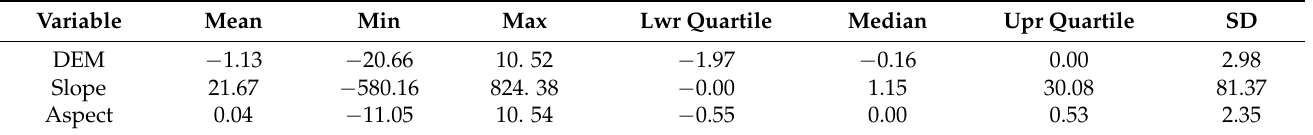
Table 1. Parameter estimation and test results of the GWR